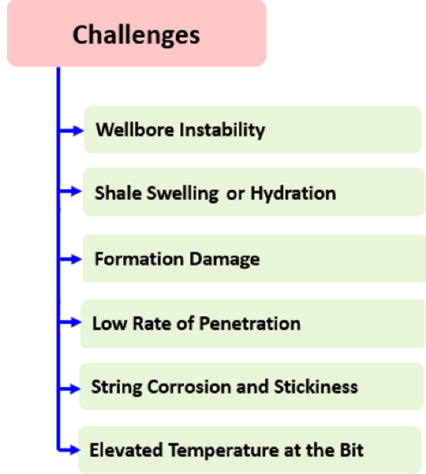
Figure 11. Challenges of drilling operations. Reproduced with permission from [139]. Copyright Elsevier, 2019.